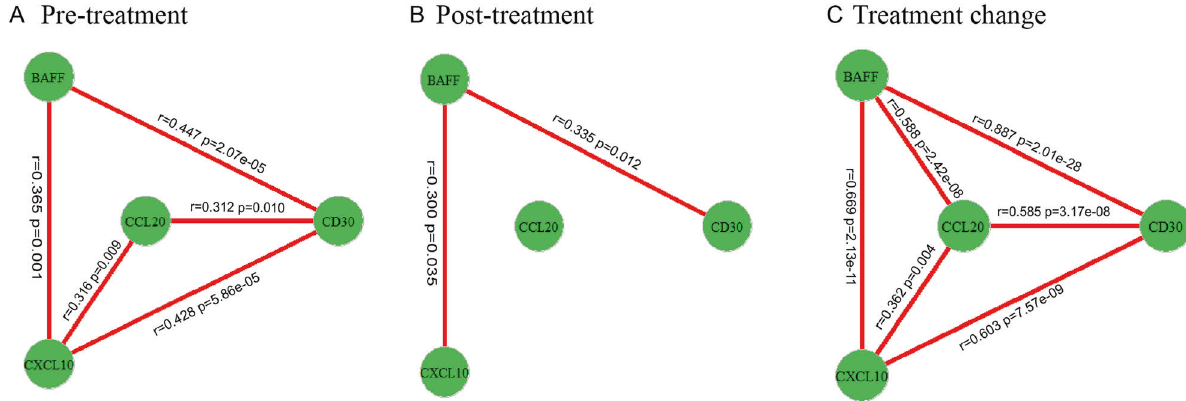
Fig. 2 The correlation of state-related IRFs during treatment. A Pre-treatment correlation; B Post-treatment correlation; C Changes of treatment correlation. The altered IRF was considered to be a node in the network, and these nodes were connected by lines if there was evidence that they were associated by Pearson correlation analysis after Bonferroni correction. Pearson ’ s r and corrected p values were shown on the graph.